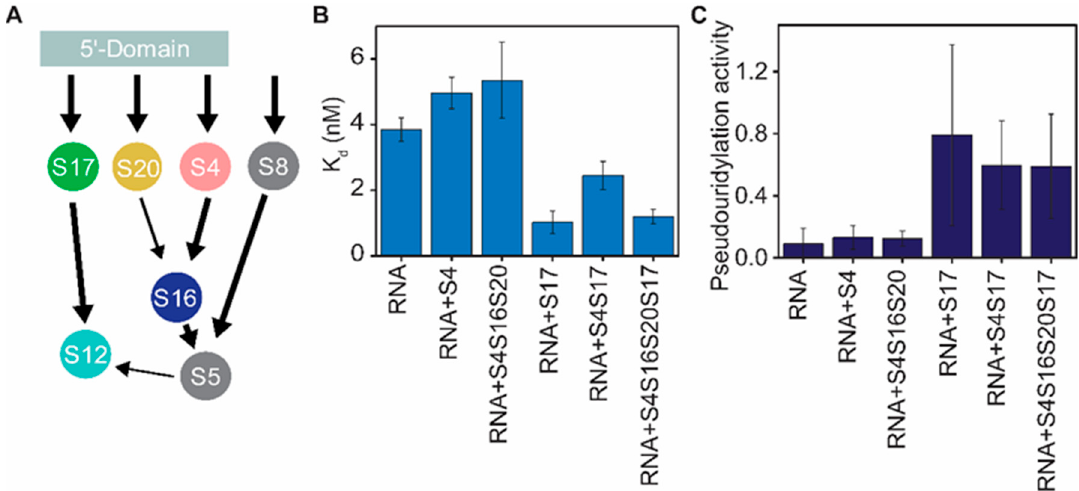
Figure 4. Binding affinity and enzymatic activity of protein RsuA vary with different combinations of ribosomal proteins. ( A ) The Nomura map of 30S 5 ′ -domain assembly. S12 binding also requires the presence of S8 (gray) and S5 (gray) that bind to the 30S central domain. ( B ) Binding affinities and ( C ) Pseudouridylase activities of protein RsuA (4 mM MgCl 2 ) in the presence of various combinations of proteins S4, S17, S20, and S16. Error bars represent propagated errors for biological triplicates.